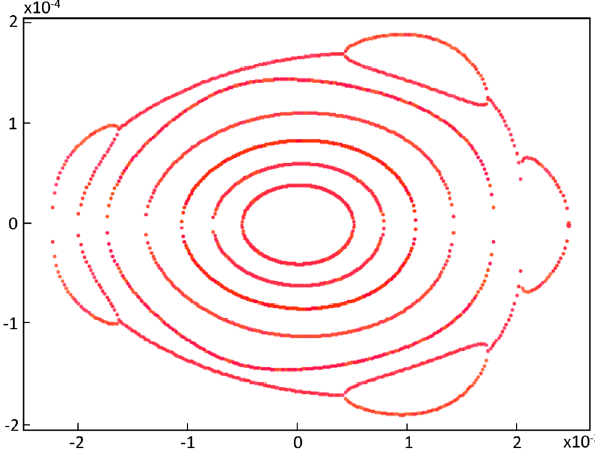
Figure 3. Horizontal phase space ( x , p x ) for the initial set of sextupoles { S 0 } given by Eq. (25). The used amplitudes x 0 are 0.5, 0.75, 1.0, 1.25, 1.45, 1.53 mm. Only representative resonances and internal tori are depicted. Units in the plot are